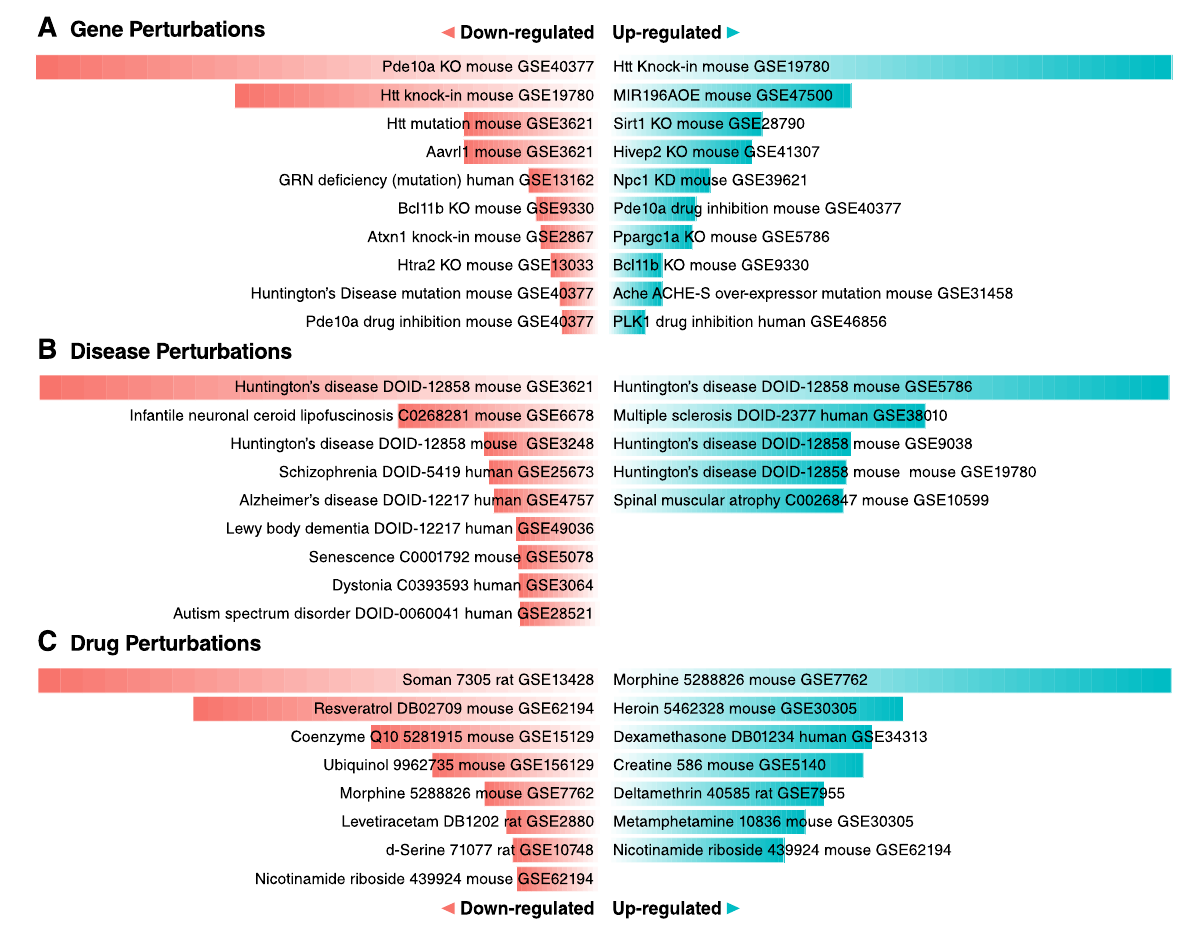
Figure 2. Transcriptional profile of Bcl11b deletion is highly correlated with HD mouse models and postmortem human HD tissue. ( A ) Gene perturbation enrichment analysis. ( B ) Disease perturbation enrichment analysis. ( C ) Drug perturbation enrichment analysis.